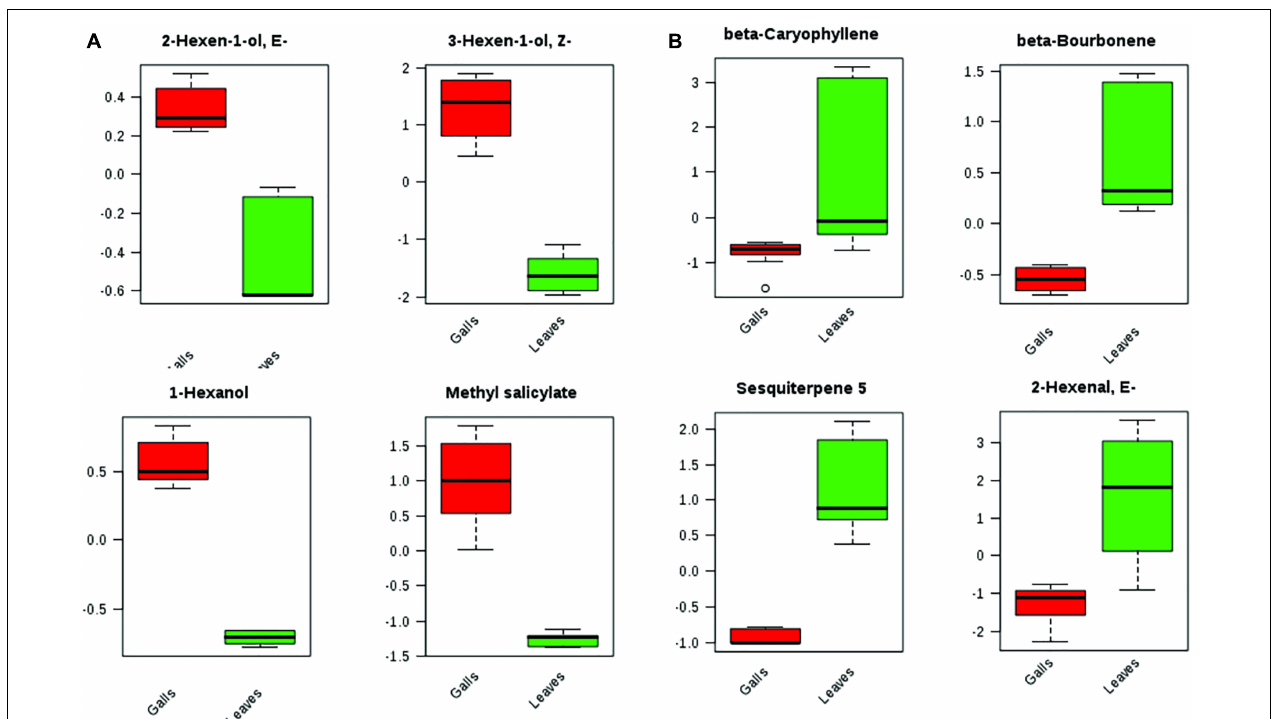
FIGURE 6 | Box plots of top metabolites that significantly differed between leaves and galls. (A) VOCs up regulated in gall samples. (B) VOCs down regulated in gall